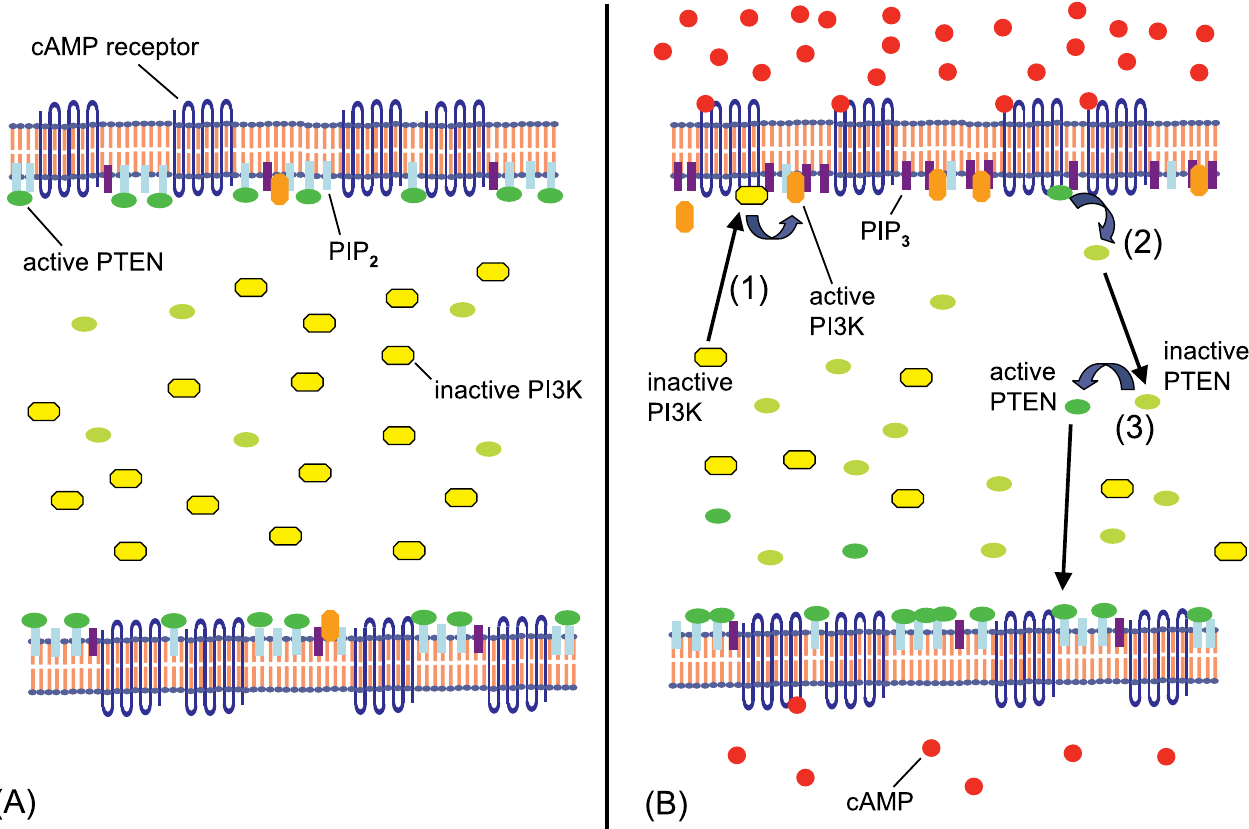
Figure 1. Standard Model of the Extracellular and Intracellular Distribution of Key Components of Dictyostelium Chemotactic Signaling (A) In an unstimulated cell PTEN is homogeneously distributed at the membrane. The cell membrane contains very little PIP 3 . (B) Stimulation of the cell leads to the membrane recruitment and activation of PI3K, as indicated by the arrows (1) leading from inactive, mainly cytosolic PI3K (yellow) to membrane-proximal, active PI3K (orange). Activated PI3K transforms PIP 2 into PIP 3 . PTEN is deactivated following cAMP stimulation and leaves the membrane. This process is indicated by arrows (2) connecting active PTEN (dark green) and the mainly cytosolic inactive PTEN (light green). Regulatory processes lead to reactivation of PTEN (3). Differences in the speed and degree of cAMP receptor ligation between front and back of the cell lead to preferential accumulation of PTEN at the back of the cell. As a result, the front experiences a higher concentration of PI3K and a lower concentration of PTEN than the back and accumulates PIP 3 . Note: To emphasize the changes in PIP 3 content, the amount of PIP 3 relative to that of PIP 2 has been overstated. Even after cAMP stimulation, the actual amount of PIP 2 will be much higher than that of PIP 3 . DOI: